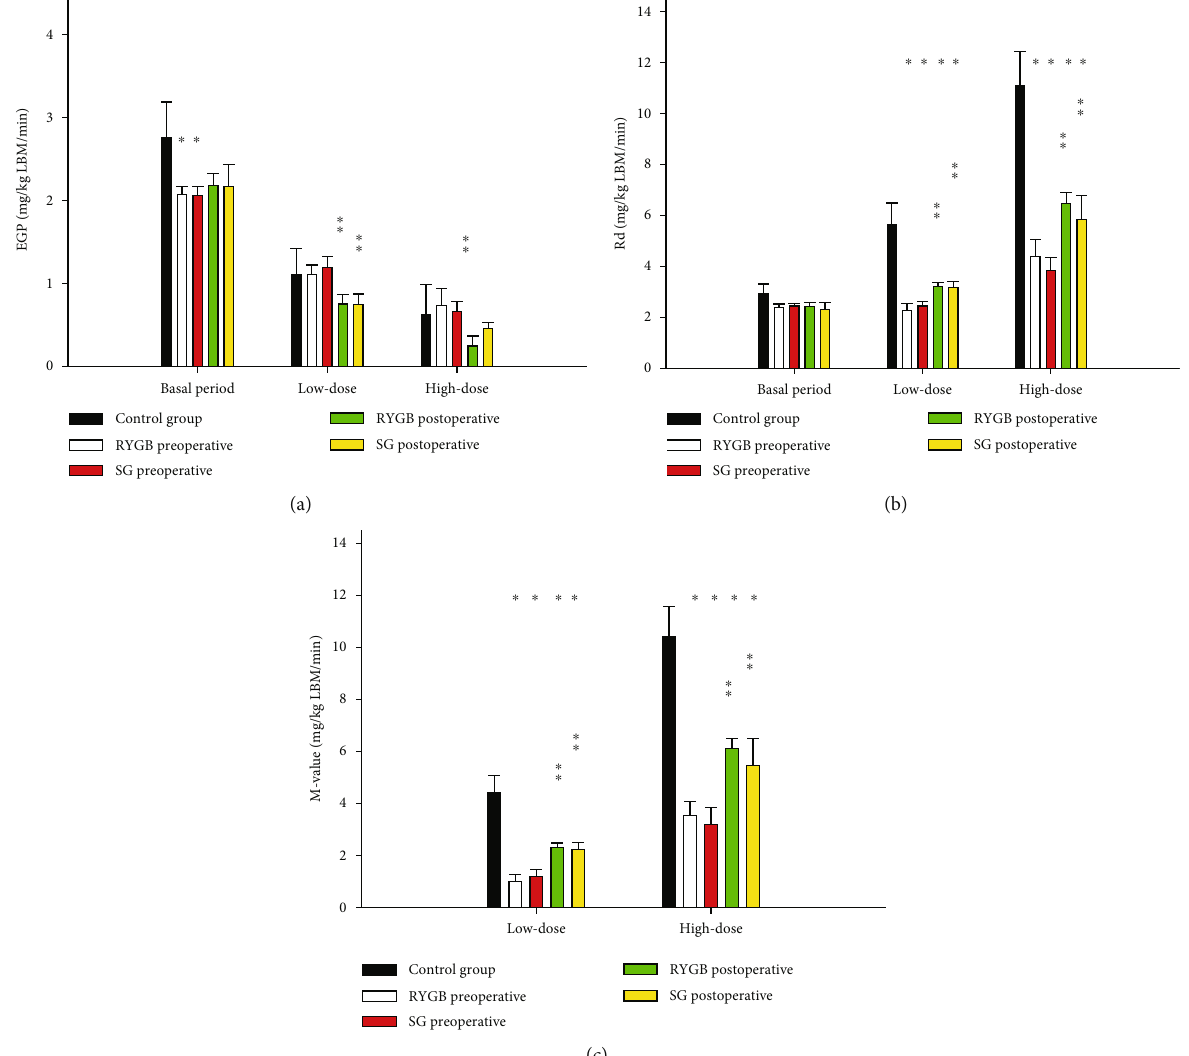
Figure 2: EGP, RD, and M -values. Displayed as the mean with the standard error of the mean. p values < 0.05 are considered statistical signi fi cant. ∗ Signi fi cant di ff erence from the control group. ∗∗ Signi fi cant di ff erence between post- and preoperative values within each group. ∗∗∗ Signi fi cant di ff erence between RYGB and SG preoperative. Abbreviations: Rd: rate of disappearance; EGP: endogen glucose production; low dose: low-dose insulin infusion; high dose: high-dose insulin